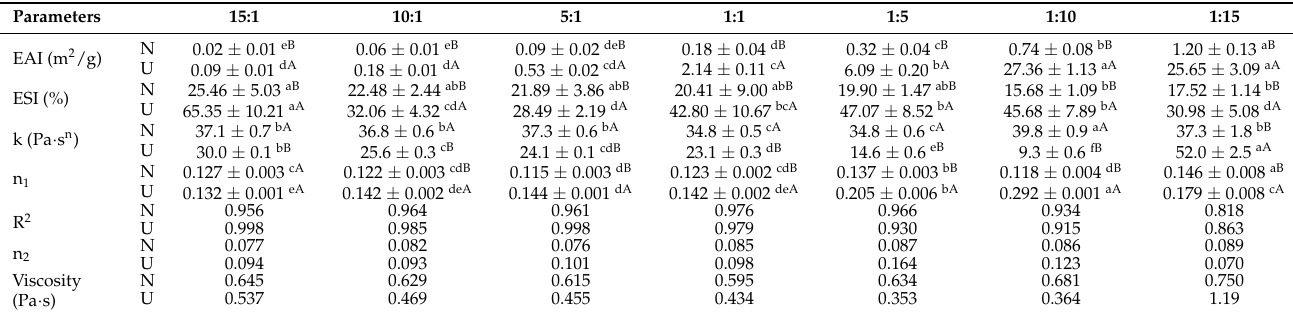
Table 1. Changes in emulsifying activity index (EAI), emulsifying stability index (ESI), viscosity coefficients (k), flow index (n 1 and n 2 ), coefficient of determination (R 2 ) and viscosity (when the shear rate was 100 s − 1 ) of emulsion before (non-ultrasound, N) and after ultrasound (U) emulsification